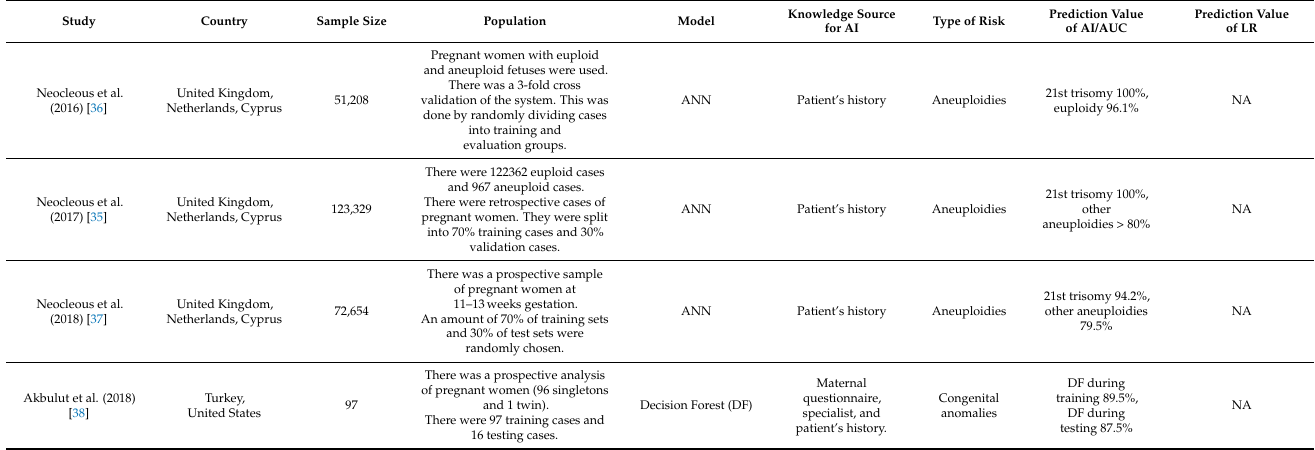
Table 3. Characteristics of included studies on prenatal diagnosis of chromosomal